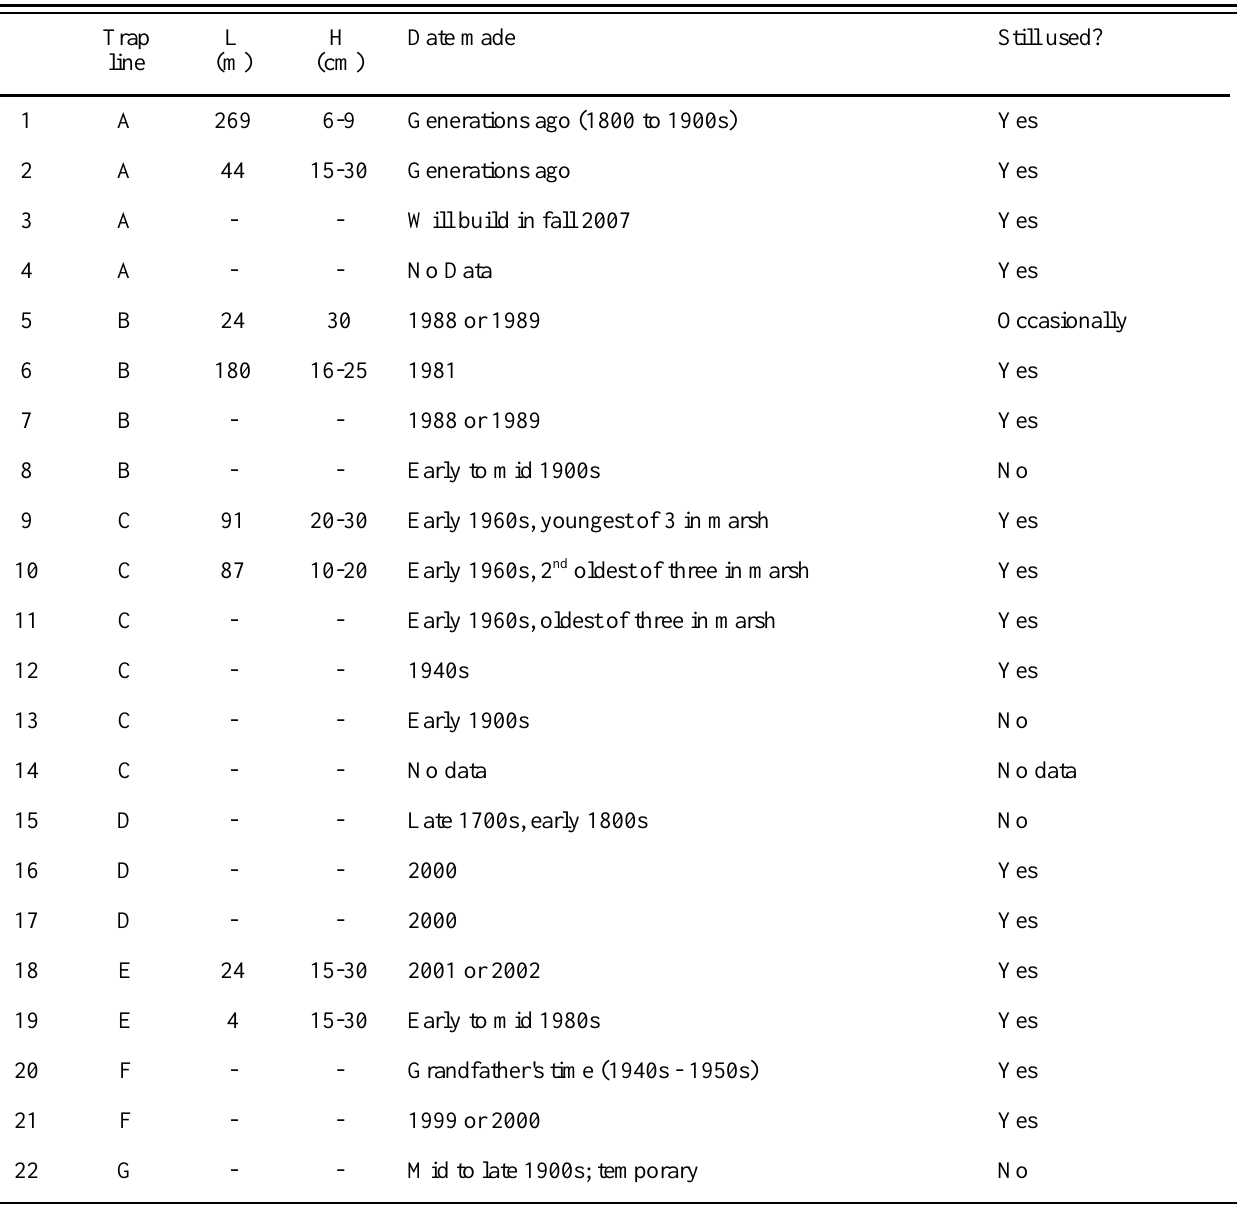
Table 1 . Dyke lengths (meters), heights (centimeters), creation dates, and use status inventoried during interviews and/or field visits organized by hunting territory. Hunting territory or trapline codes have no relation to spatial distribution of